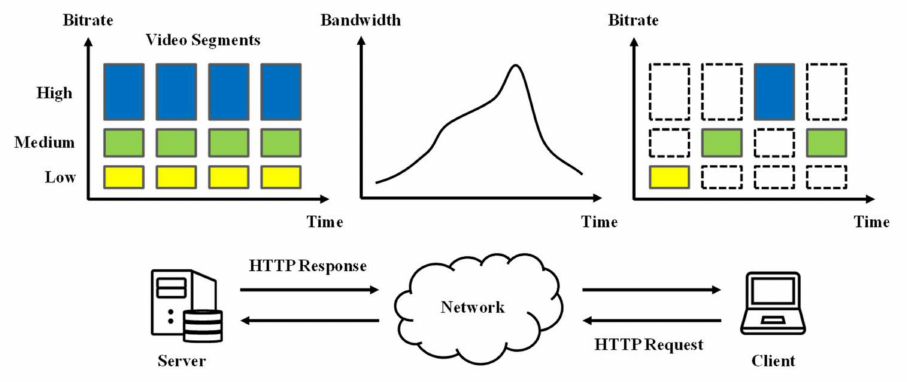
Figure 1. Concept of DASH-based bitrate